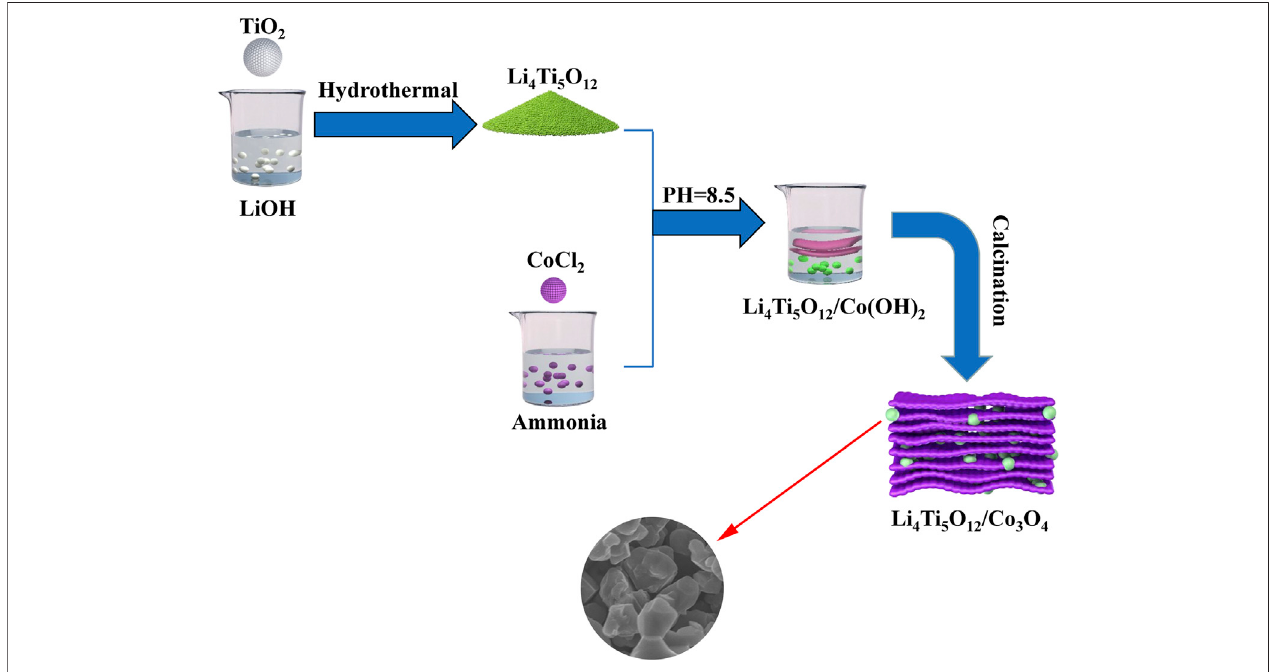
FIGURE 1 | Schematic diagrams of the synthesis of the Li 4 Ti 5 O 12 /Co 3 O 4 composite.